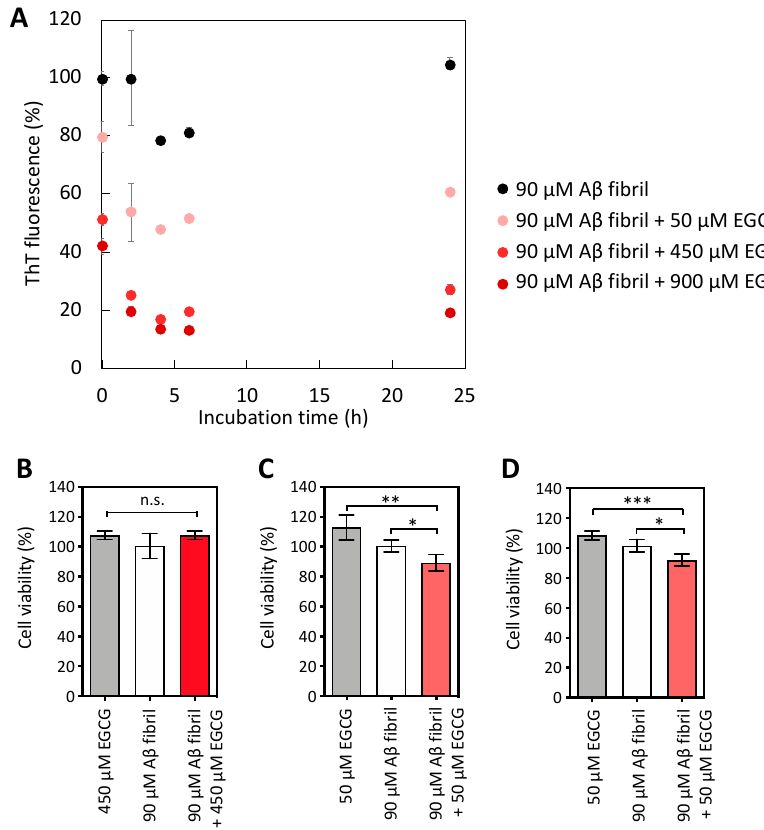
Figure 1. Concentration- and time-dependent effects of epigallocatechin gallate (EGCG) on the amyloid β (A β ) fibril disaggregation and cytotoxicity. ( A ) Normalized Thioflavin T (ThT) fluorescence intensity during fibril disaggregation in the presence of different molar ratios of EGCG. The fluorescence intensity of A β fibrils without compounds at 0 h is indicated as 100%. The mean ± standard deviation (SD) is shown on the graph (N = 3). The cytotoxicity of A β samples disaggregated in ( B ) 450 µM of EGCG for 24 h, ( C ) 50 µM of EGCG for 6 h, and ( D ) 50 µM of EGCG for 24 h was investigated using the MTS assay. Additionally, 100% cell viability represents the cell viability when incubated with the solvent control: diluted dimethyl sulfoxide with phosphate-buffered saline. The cytotoxicity data are shown as the mean ± SD on the graph (N = 4). Statistical analysis was performed using a two-way analysis of variance (ANOVA) with Tukey’s multiple comparison test: * p < 0.05, ** p < 0.01, and *** p < 0.001.